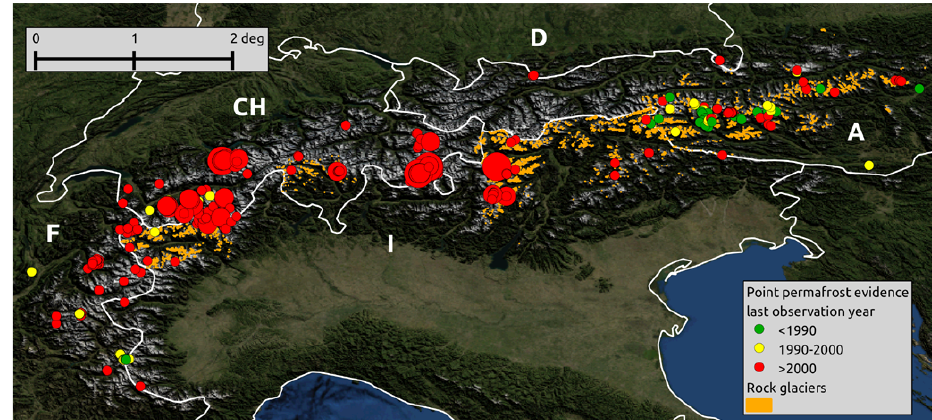
Fig. 1. Map of the permafrost evidence acquired in the Alps. The dots represent point permafrost evidence. The colors of dots represent the classes of last observation dates confirming permafrost state (before 1990, between 1900 and 2000, after 2000). The size of the dots indicates 3 classes ( < 3yr, 3–8yr, > 8yr) representing the length of observations/measured data associated with each evidence. Orange polygons represent rock glacier inventories.